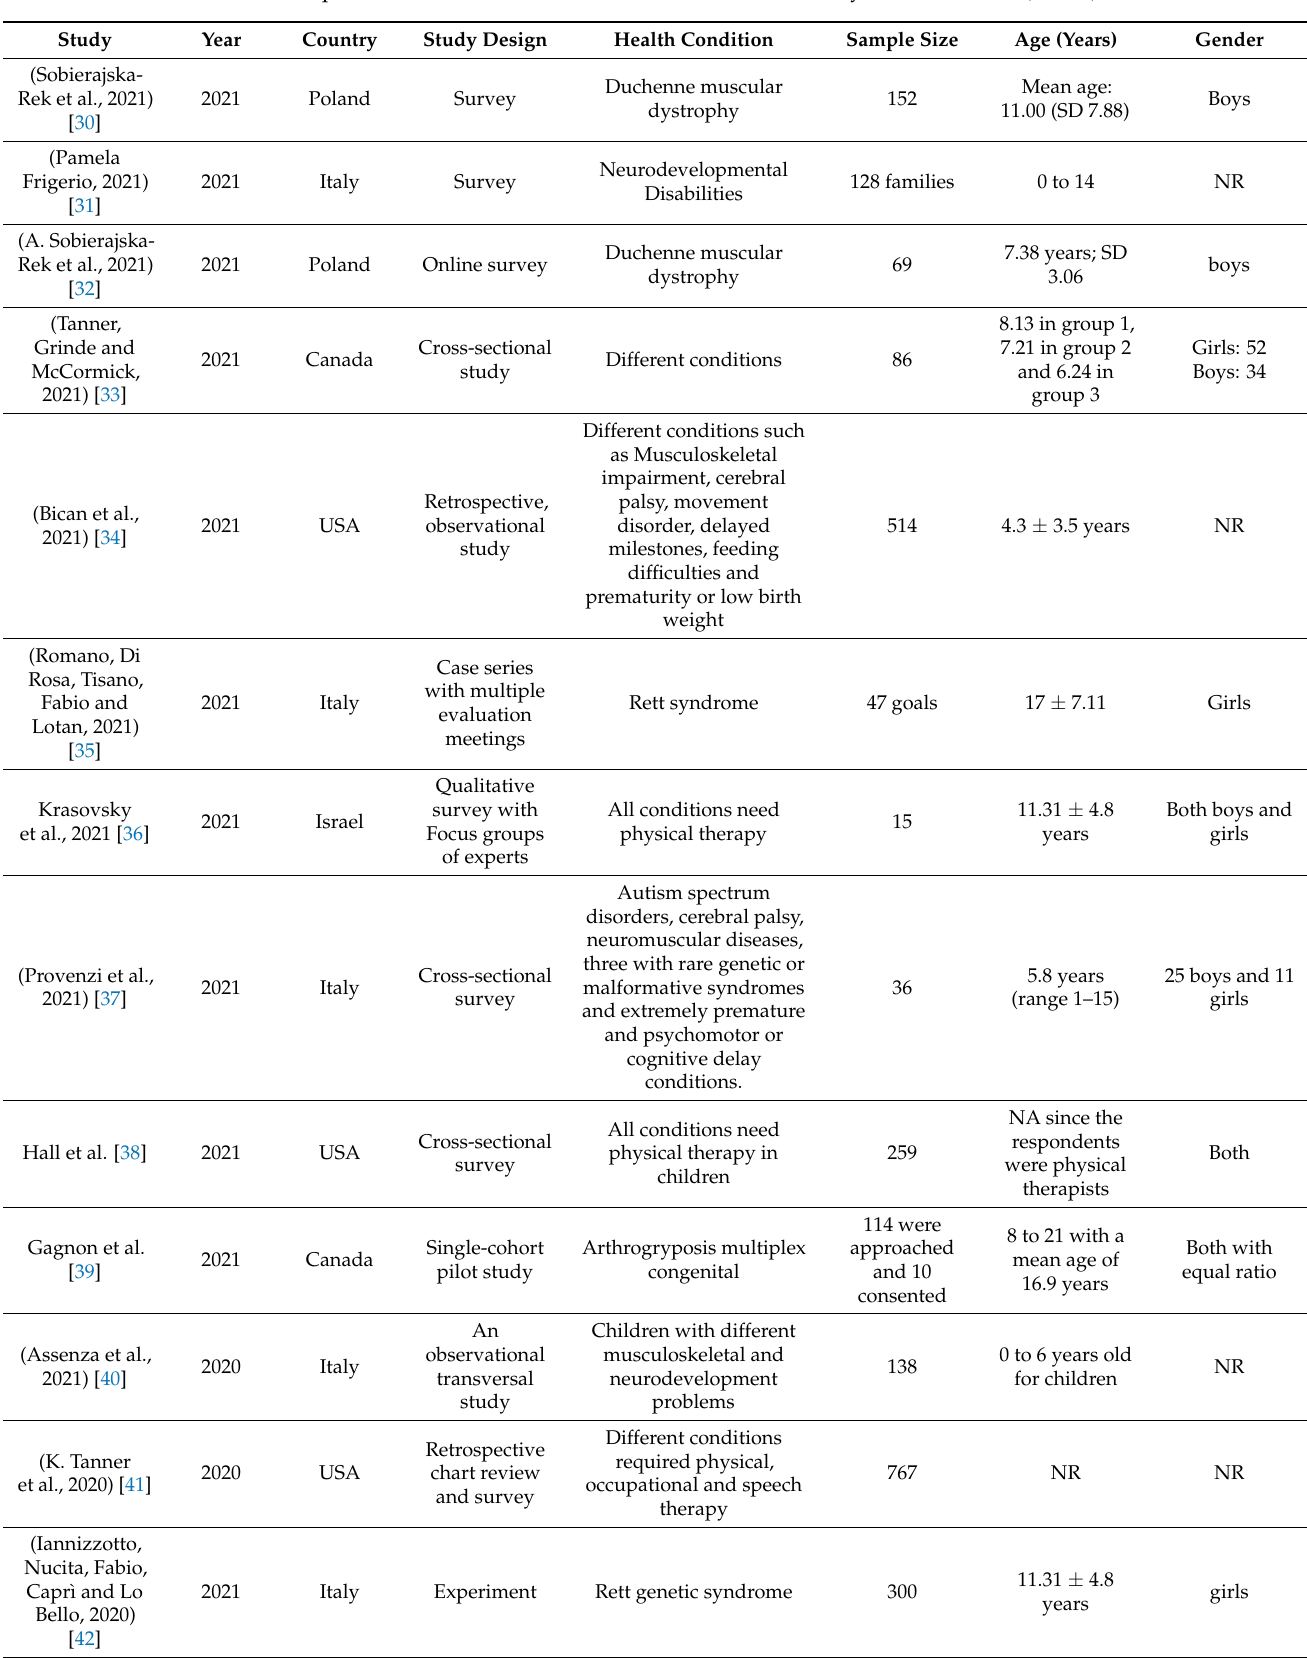
Table 2. Important characteristics of the included studies in the systematic review ( n =